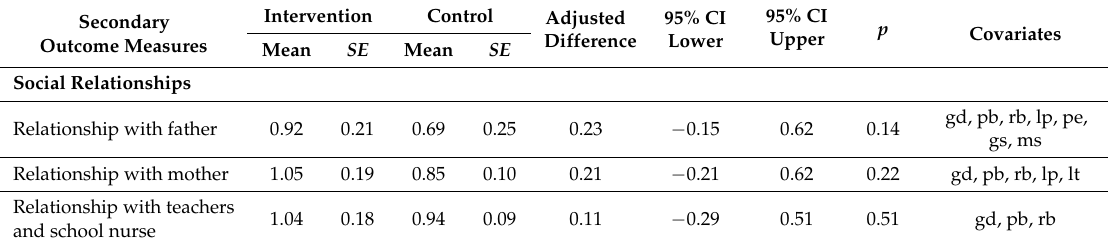
Table 6. Estimates of the social relationships among peers, parents and teachers with the students. Secondary Outcome Measures